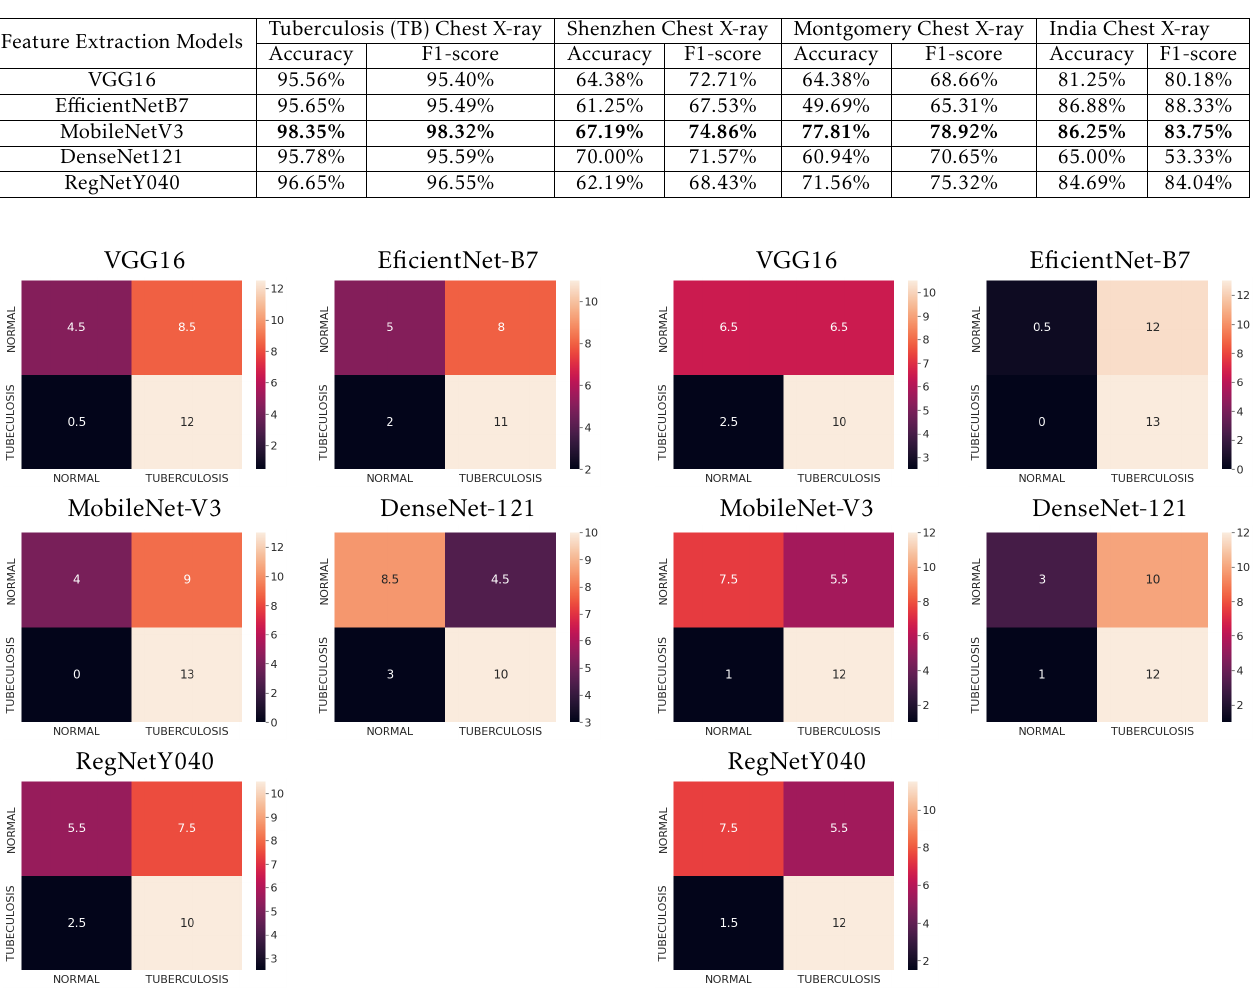
training, which has a negative impact on the spatial distribution of the object. As a consequence, in our research, we continue to keep the datasets separate in order to preserve the specificity of spatial distribution.